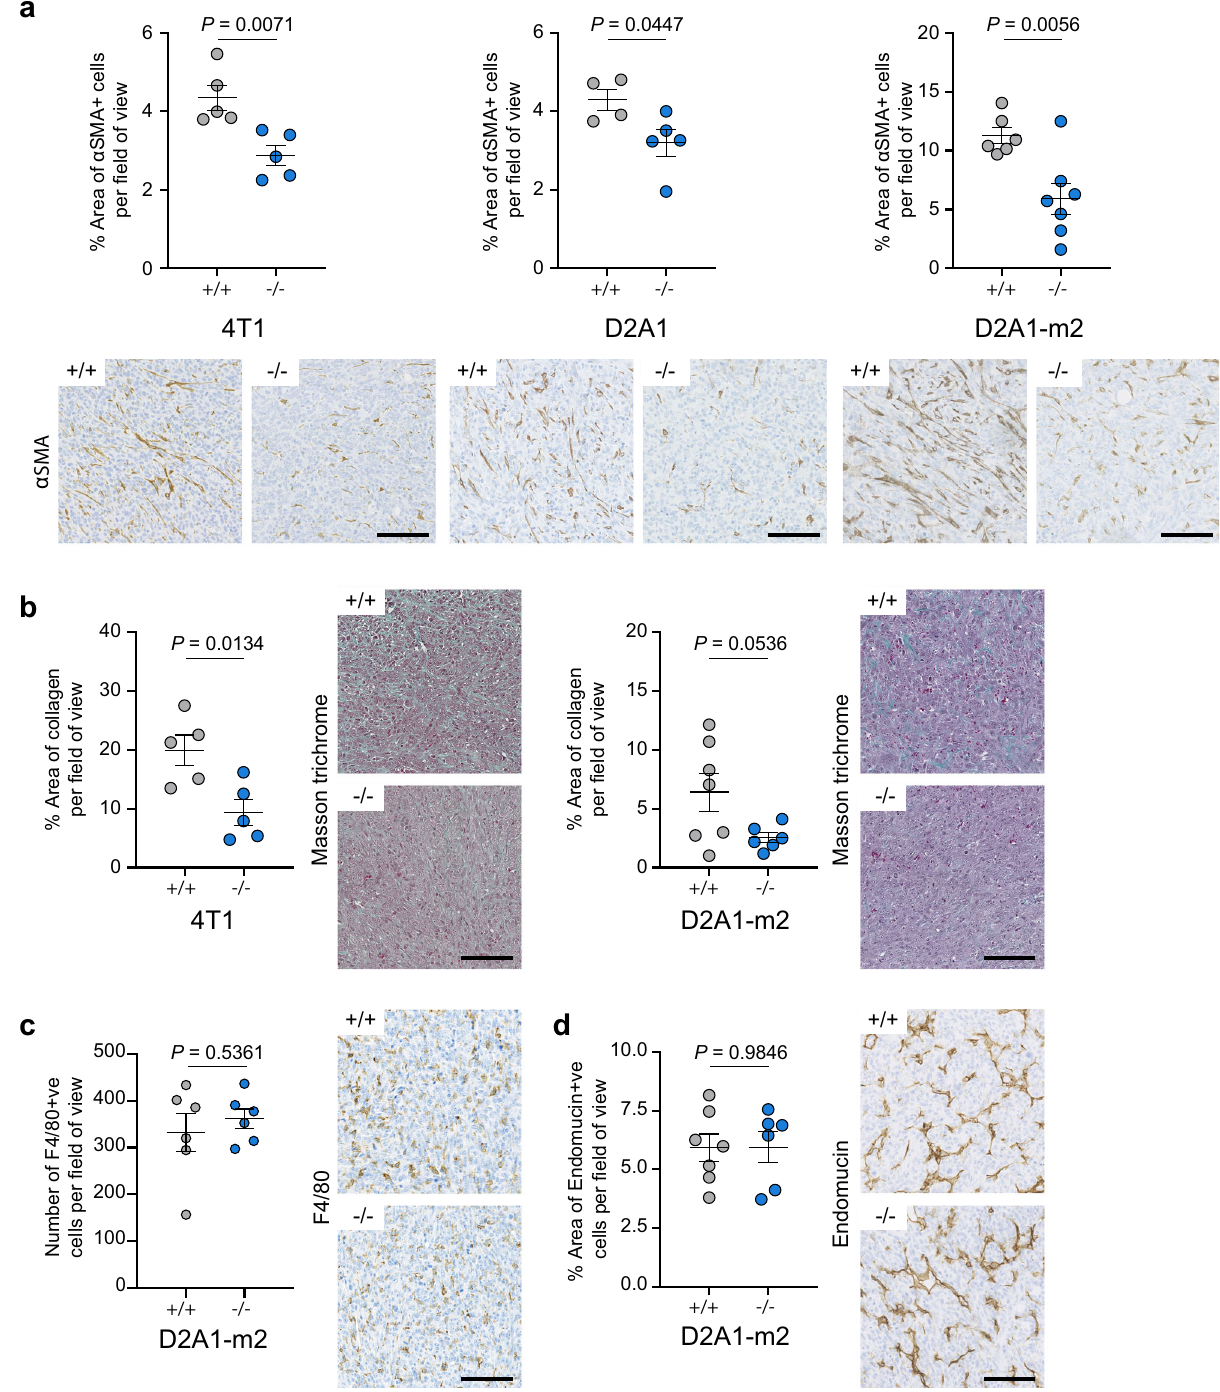
Fig. 7 Reduced fi broblast numbers and collagen deposition. a Analysis of intra-tumoural α SMA positive staining in 4T1, D2A1 and D2A1-m2 primary tumours grown in Endo180 + / + and Endo180 − / − mice. Data represents mean values per tumour ± SEM (4T1, n = 5 per group; D2A1, Endo180 + / + n = 4, Endo180 − / − n = 5; D2A1-m2, Endo180 + / + n = 6, Endo180 − / − n = 7; two-sided t -test) Representative images (scale bar, 100 µ m). b Analysis of intra- tumoural Masson ’ s trichrome staining of 4T1 (left panel) and D2A1-m2 (right panel) primary tumours in Endo180 + / + and Endo180 − / − mice. Data represent mean values per tumour ±SEM (4T1, n = 5 per group; D2A1-m2, Endo180 + / + n = 7, Endo180 − / − n = 6; two-sided t -test). Representative images (scale bar, 100 µ m). c Analysis of intra-tumoural F4/80 staining of D2A1-m2 primary tumours in Endo180 + / + and Endo180 − / − mice. Data represent mean values per tumour ±SEM ( n = 6 per group; two-sided t -test). Representative images (scale bar, 100 µ m). d Analysis of intra-tumoural endomucin staining of D2A1-m2 primary tumours. Data represent mean values per tumour ±SEM (Endo180 + / + n = 7, Endo180 − / − n = 6; two-sided t -test). Representative images (scale bar, 100 µ m). Non-signi fi cant (ns) P values > 0.05. Source data are provided as a Source Data fi